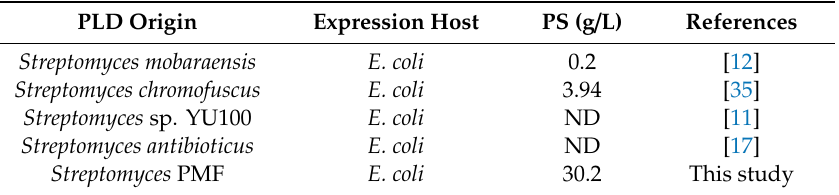
Table 1. Production of recombinant PLD in E. coli and synthesis of